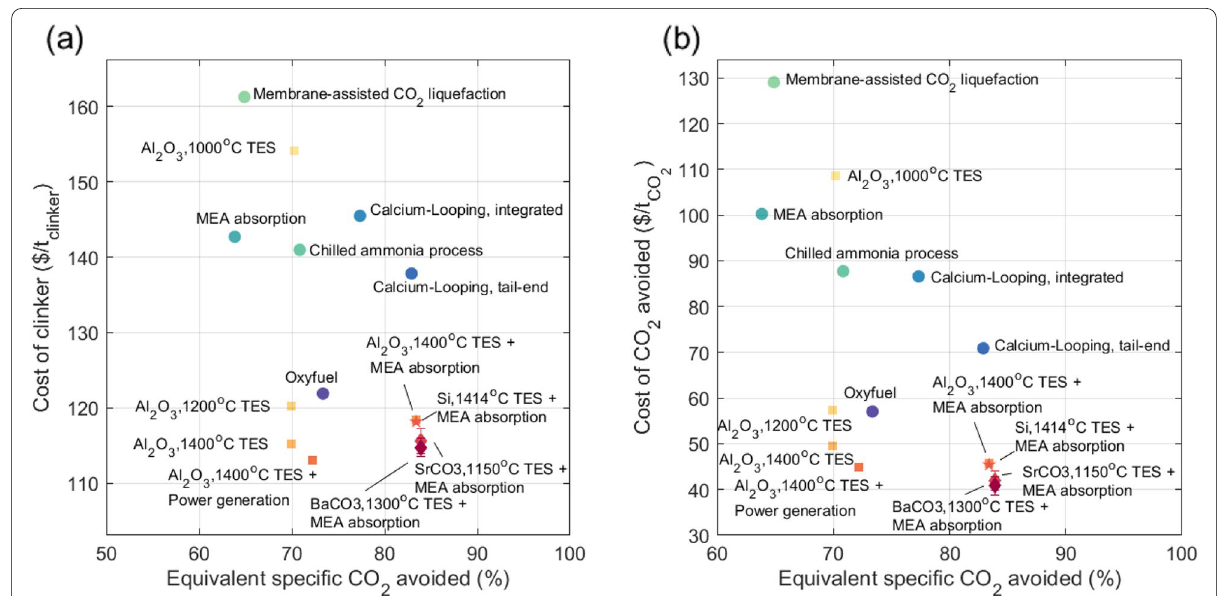
Fig. 9 The relationship between the CO 2 avoided and the economic performance of different CO 2 capture technologies